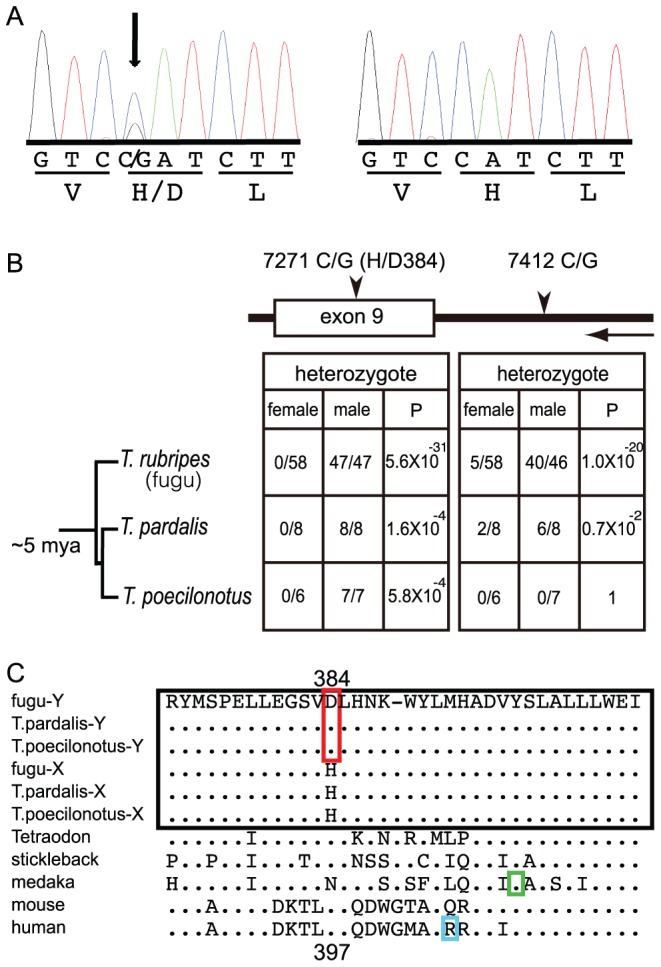
A trans-specific SNP in Amhr2 is correlated with phenotypic sex in Takifugu.(A) Sequence traces of Amhr2 from a male (left) and a female (right) fugu. The male is heterozygous at the non-synonymous SNP site that converts His384 codon into Asp384 codon. (B) Sexual phenotypes, genotypes and statistical significance of trans-species SNPs. Proportion of heterozygotes among females and males in three species of Takifugu are shown. P-values are from 2×2 Fisher's exact test of the genotype count data. A horizontal arrow indicates the transcriptional orientation of the genes. (C) Comparison of a part of kinase domain sequences of Amhr2 from various vertebrates. The sequences from Takifugu species are boxed in black. The amino acid specific to the male chromosome of Takifugu is boxed in red. His/Asp384 of fugu Amhr2 corresponds to Asp397 of human AMHR2. The position of the amino acid mutation in the medaka (hotei) that results in a female phenotype when homozygous is boxed in green. The amino acid position of a natural mutation leading to the loss-of-function of human AMHR2 is boxed in cyan.